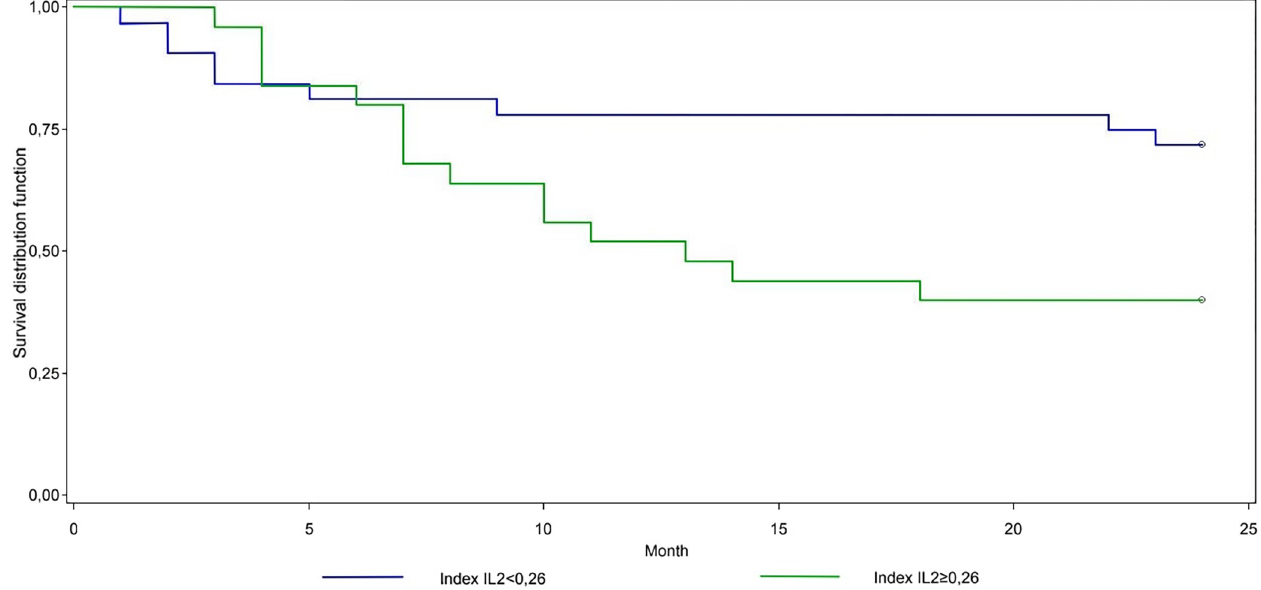
Fig 1. Relapse free interval–Index IL-2 . Fig 1 shows the survival analysis of the patients sorted according to Index IL-2 cut-off 0.26. In the univariate analysis, the difference between the two groups was statistically significant in favor of those with lower values of Index IL-2 , (p = 0.0277).